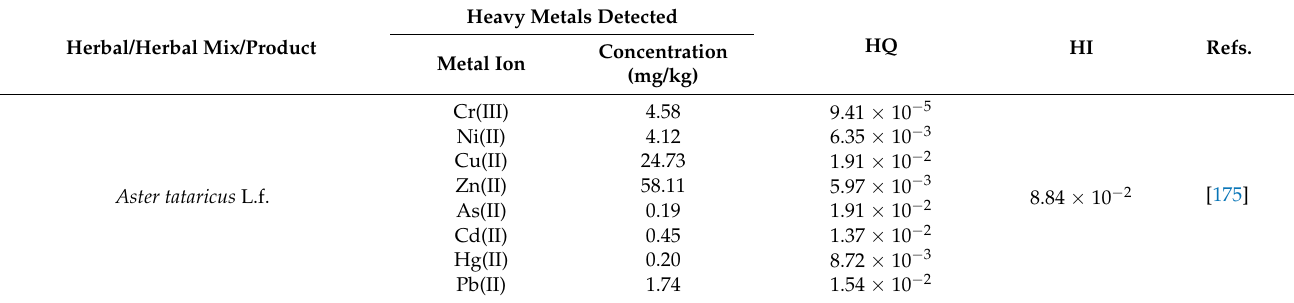
Table 4. Hazard quotient (HQ) and hazard index (HI) of heavy metals in the medicinal plants or associated